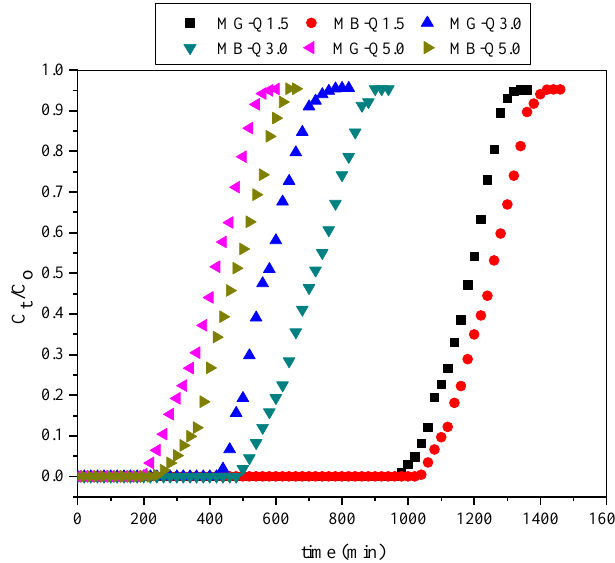
Figure 9. Breakthrough curves for adsorption of MG and MB in a binary system at a varied flow rate (pH: 9; C 0 : 50 mg / L; Z : 6 cm). Table 4. Column adsorption data for MG and MB onto T-PAA in the binary system.